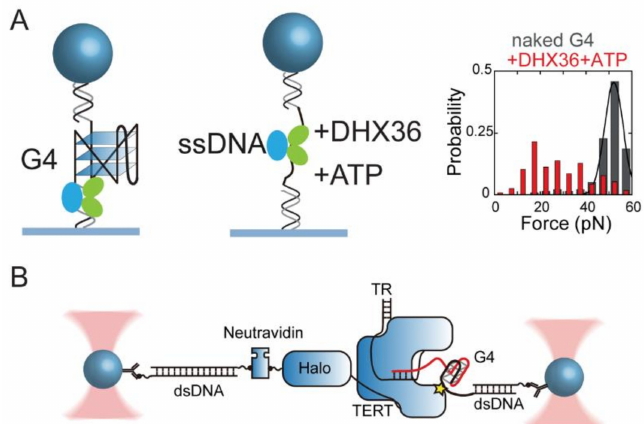
Figure 5. Example applications of force spectroscopy to study the proteins and G4 interactions. ( A ) Experimental design to measure the interaction between DHX36 (RHAU) helicase and c-Myc DNA G4 by MT. Adapted with permission from [63], Oxford Academic. ( B ) Experimental design to measure the telomerase elongation processivity by OT. Telomerase and its substrate were attached to two polystyrene beads through dsDNA handles. Adapted with permission from [65], Springer Nature